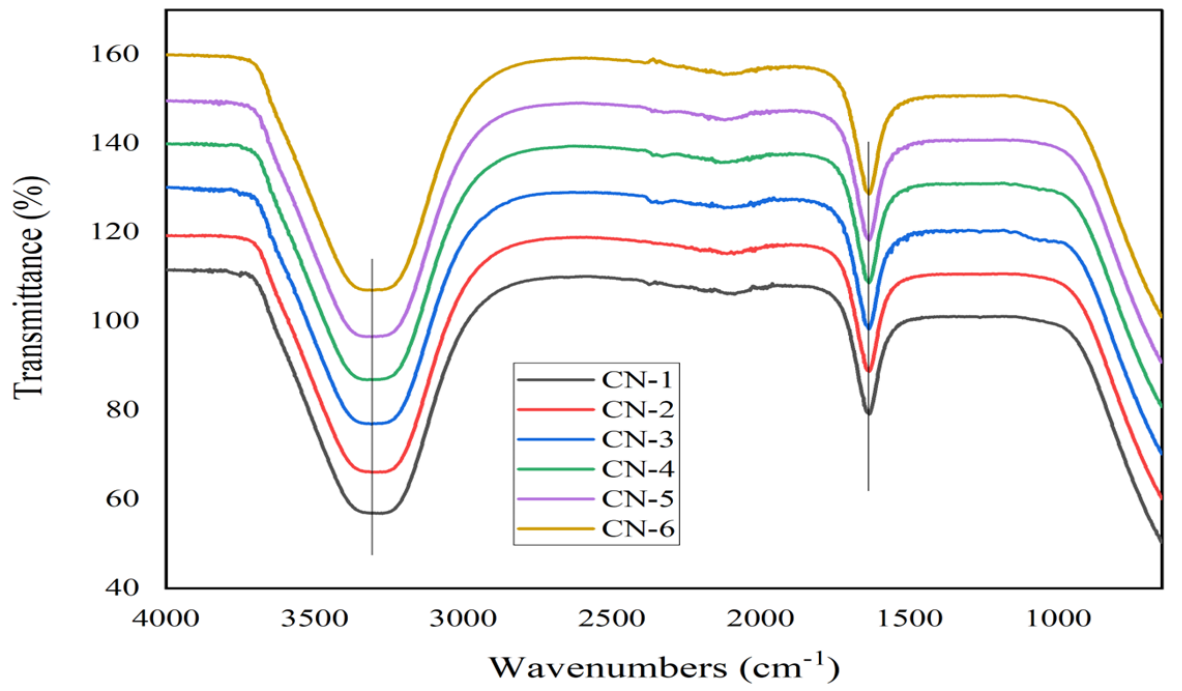
Figure 5. Comparative representation of cellulose nanocrystals’ FTIR spectra of CN-1, CN-2, CN-3, CN-4, CN-5, and CN-6.